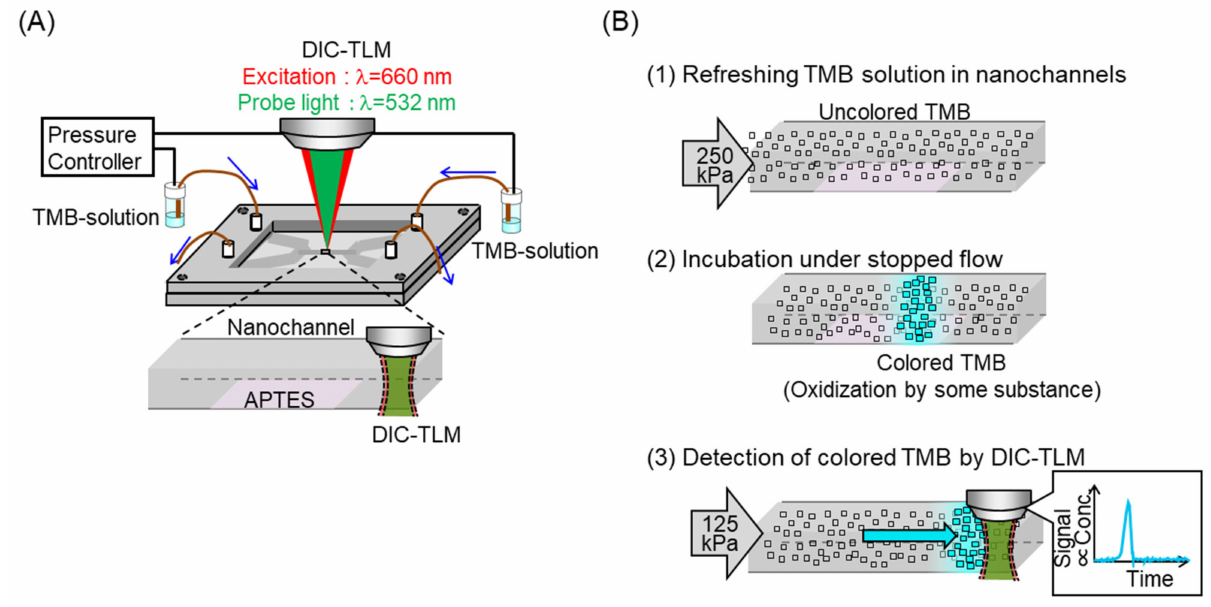
Figure 2. Evaluation of artifact on nanofluidic ELISA. ( A ) Setup. ( B ) Procedure of fluidic